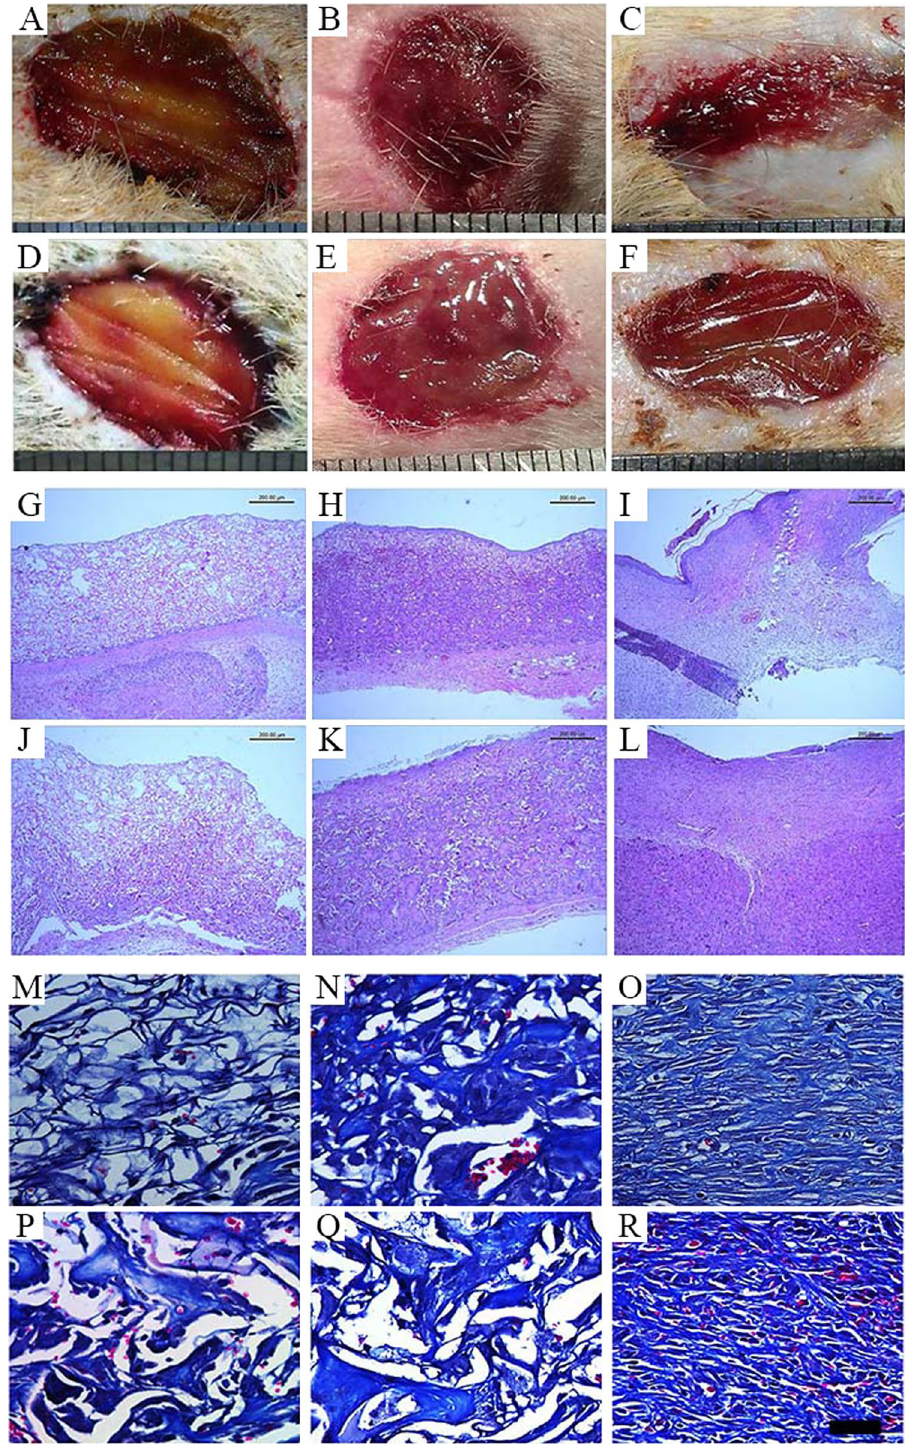
Figure 6. Gross and pathological observations of NAg-CCS ( A – C ) and CCS ( D – F ) at week 1, 2 and 4 post transplantation. Light blue indicates newly-formed collagen, and red indicates